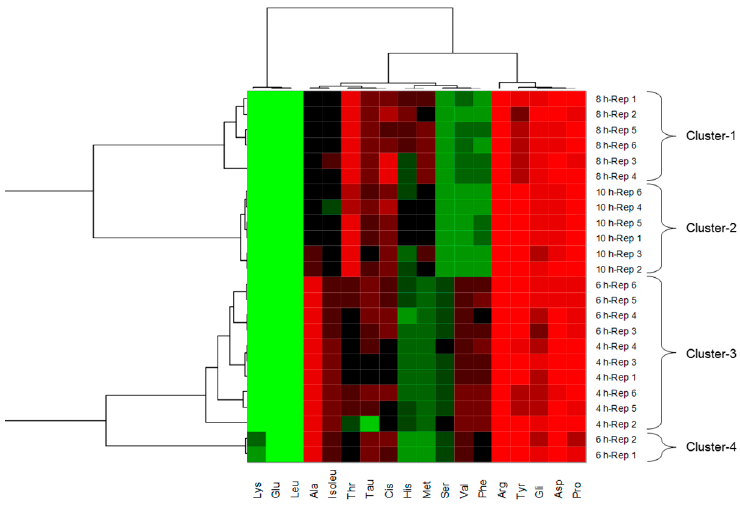
Figure 2. Heat map analysis of amino acid profiles for each porcine liver hydrolysates. Six replicates were generated at different hydrolysis times (4, 6, 8, and 10 h) by Flavourzyme.